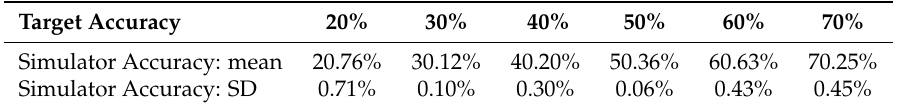
Table 2. Accuracy of the simulated classifier. The accuracies of the simulated classifier were averaged over 10 trials.